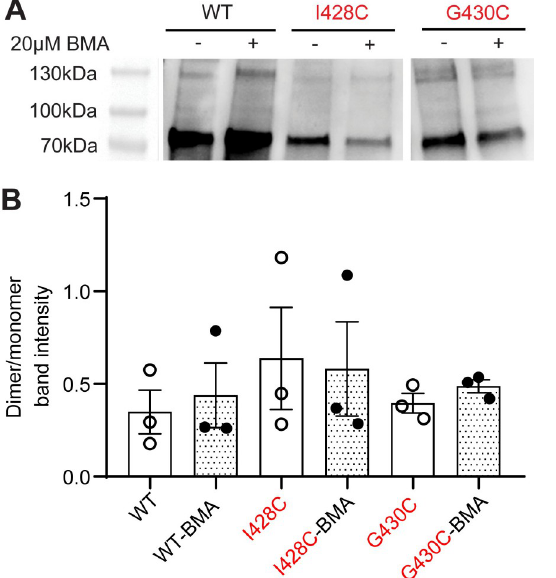
Fig 6. No evidence in western blot analysis for intersubunit cross-linking by BMA in I428C and G430C mutants. Cell surface-expressed proteins of transfected CHO cells were isolated by biotinylation, separated by SDS-PAGE and transferred to Western blot, and ASIC1a was detected by a specific antibody. A . Representative Western blots, showing the bands of monomeric ASIC1a at 70kDa, and the bands of the subunit dimer at 130kDa for the indicated constructs. The blot of WT and I428C originates from blot 1 (S1 Raw images), while that of G430C originates from blot 2. B , Ratio between dimeric to monomeric band intensity, n =